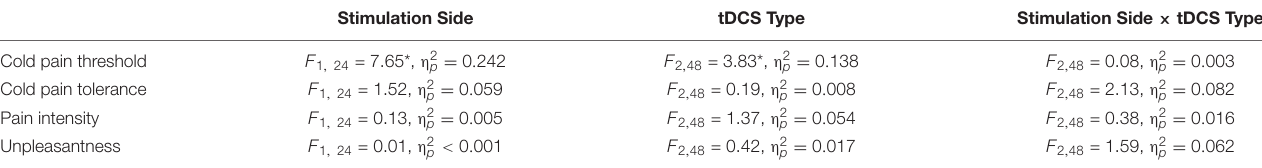
TABLE 3 | Statistics for cold pain sensitivity.